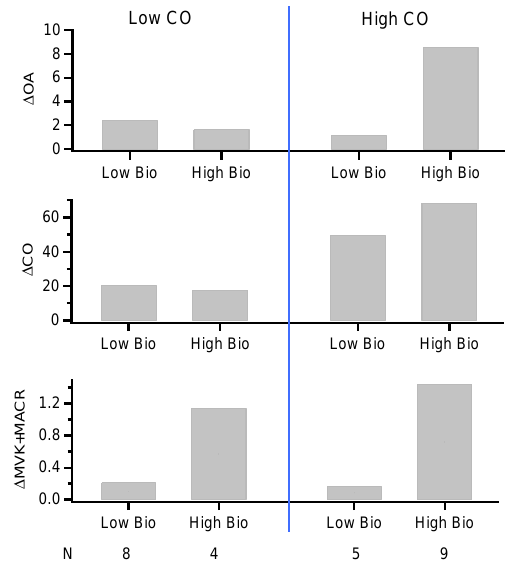
Figure 9. Bar graphs for subsets defined on the basis of (cid:49) CO and (cid:49) MVK + MACR. Same format as Fig. 8.